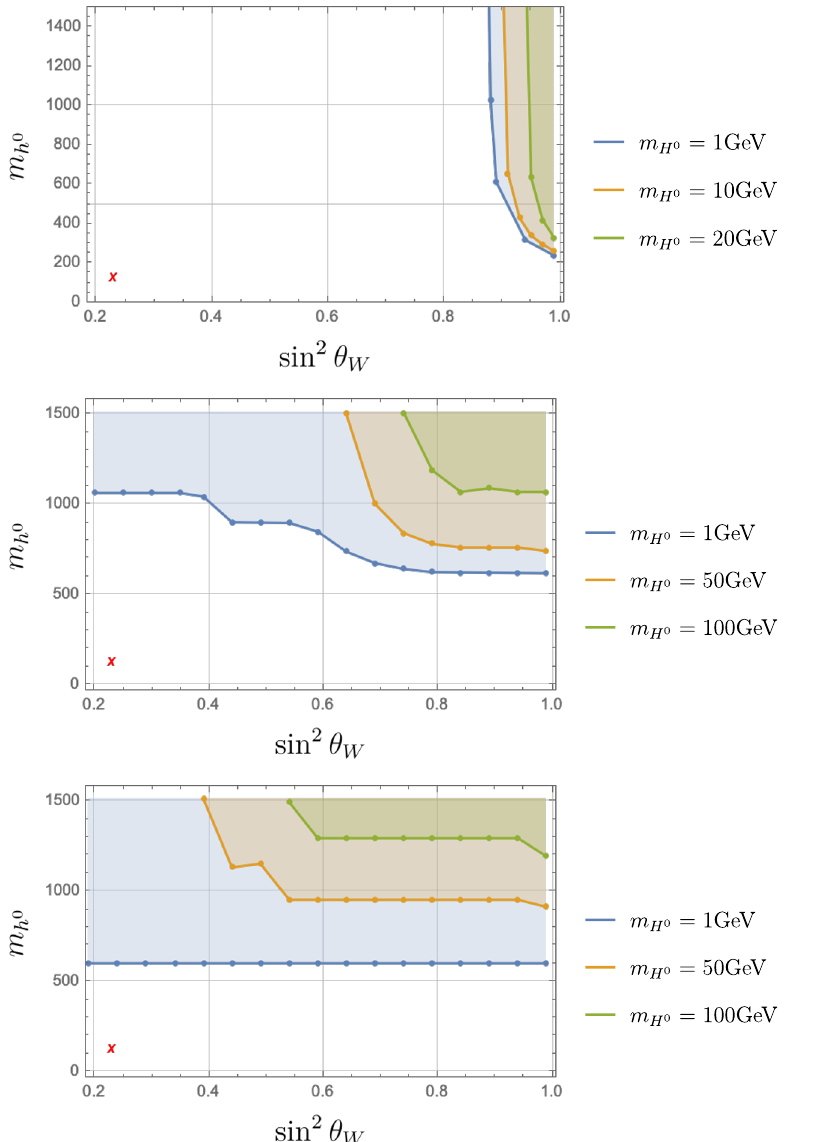
Figure 9 . Stability of the molecule string. The molecule is stable in the shaded regions. The unit of the vertical axis is GeV. The top, middle, and bottom panels correspond to m 110 , 500 , 750 GeV, respectively. The physical point ( m by the red